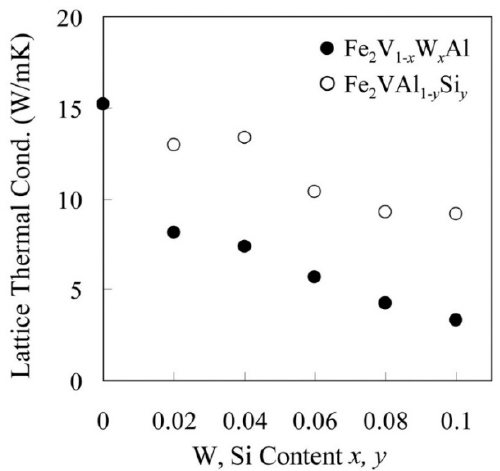
Figure 2. Lattice thermal conductivity at 300 K in nanostructured Fe 2 V 1− y W y Al and Fe 2 VAl 1− x Si x as a function of W or Si concentration. Reproduced from [27], with copyright permission from American Institute of Physics, 2012.